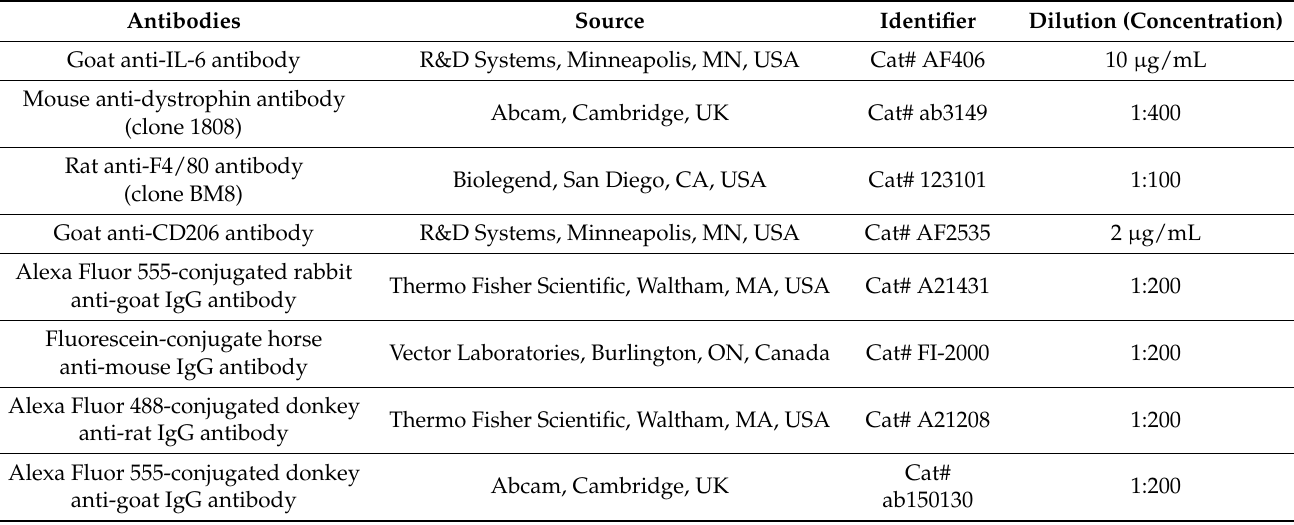
Table 2. Antibodies for